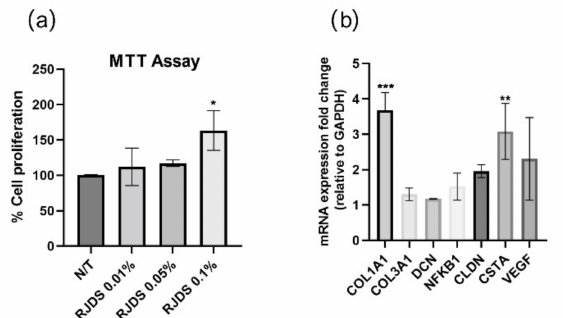
Figure 2. Results from in cellulo assays in NHDF cells. ( a ) Cell proliferation results based on MTT assay for untreated NHDF cells (N/T) and NHDF cells treated with different concentrations of RJDS diluted in the cell-culture medium (0.01%, 0.05%, 0.1% v / v ). Value for untreated cells was arbitrarily set to 100% * p < 0.05 indicates groups significantly different from the control (ANOVA test—Dunett multiple comparisons test). ( b ) Relative gene expression levels for Col1A1, Col3A1, DCN, NFKB1, CLDN, CSTA and VEGF expressed as a fold change ± SEM compared to the control NHDF cells and using GADPH as internal reference gene. The experimental conditions were control (untreated NHDF cells—N/T) and cells treated with RJDS dissolved in cell culture medium in the percentage of 0.1% v / v ). *** p < 0.001, ** p < 0.01 indicates groups of significantly different from the control (ANOVA). The data correspond to the mean ± SEM of three independent